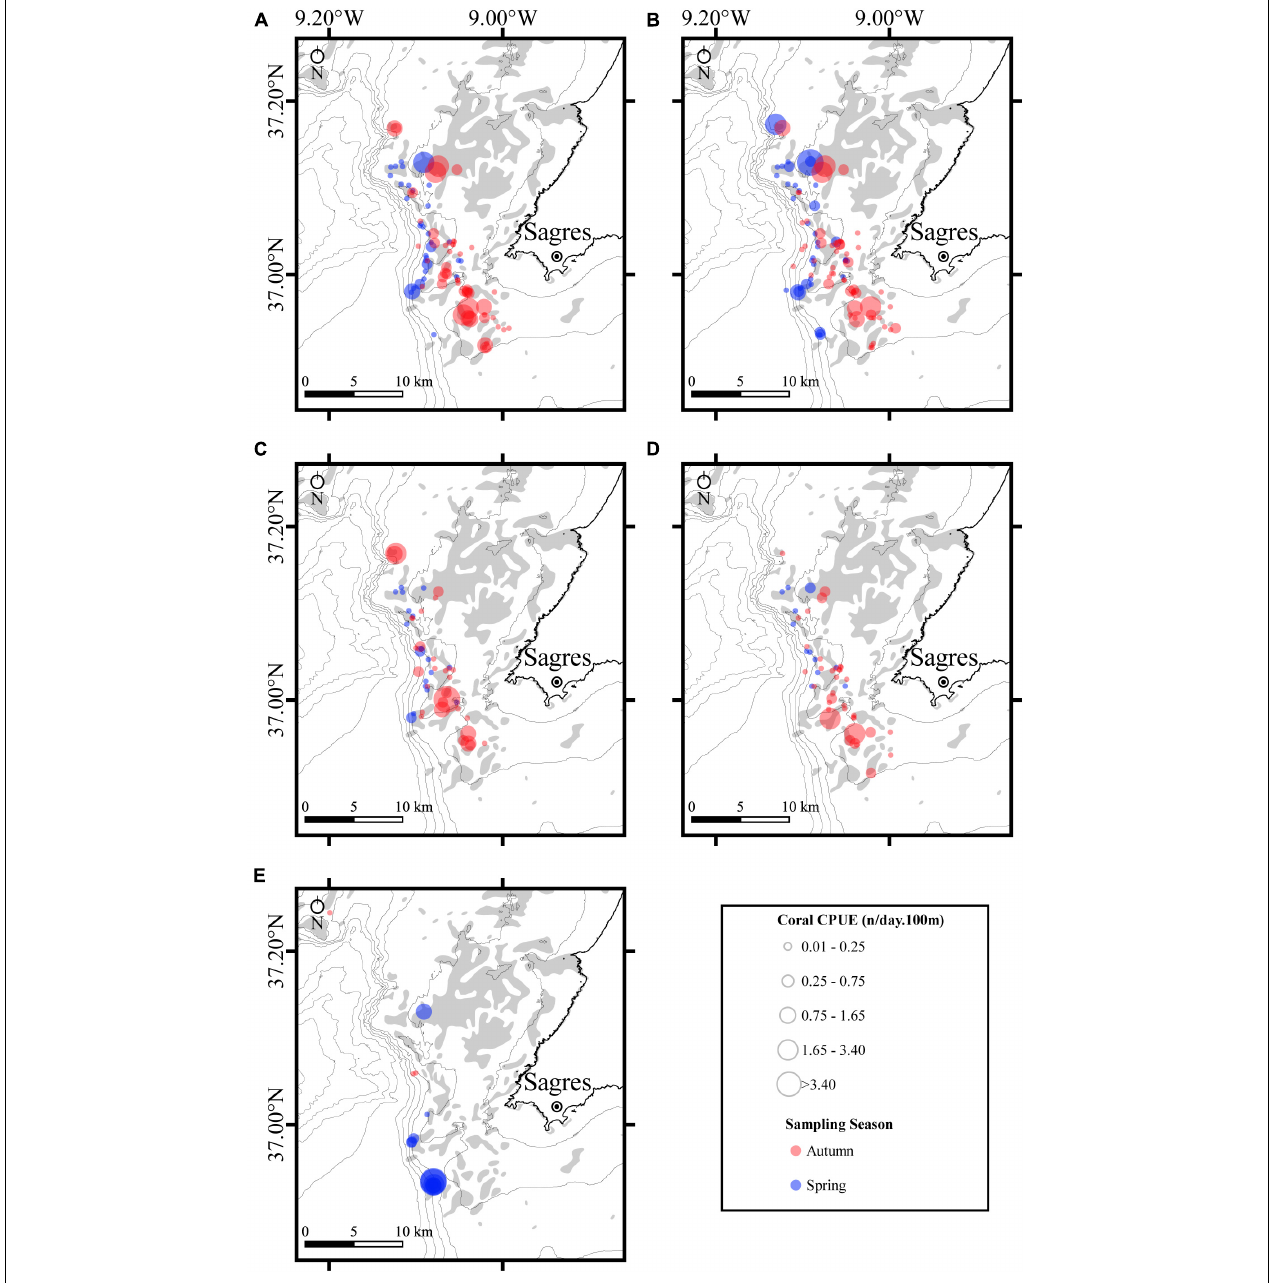
FIGURE 6 | Spatial distribution of the fishing effort for the five specimens of coral caught as bycatch in bottom-set-gillnets off the coast of Sagres (Portugal) during summer-autumn (blue color) and spring (red color) sampling seasons. Fishing effort was calculated as the catch per unit of effort (CPUE) and represents the number of specimens (coral) as a function of the product of the net soaking time (days) and 100 m of net length deployed. (A) Paramuricea grayi ; (B) Eunicella verrucosa ; (C) Dendrophyllia cornigera ; (D) Dendrophyllia ramea ; and (E) Callogorgia verticillata . CPUEs for the corals are displayed as bubbles. Bathymetric isobaths are as follows: 50 m, 100–500 m (increments of 100 m), and > 500 m (increment of 200 m). Rocky substrate is represented as gray